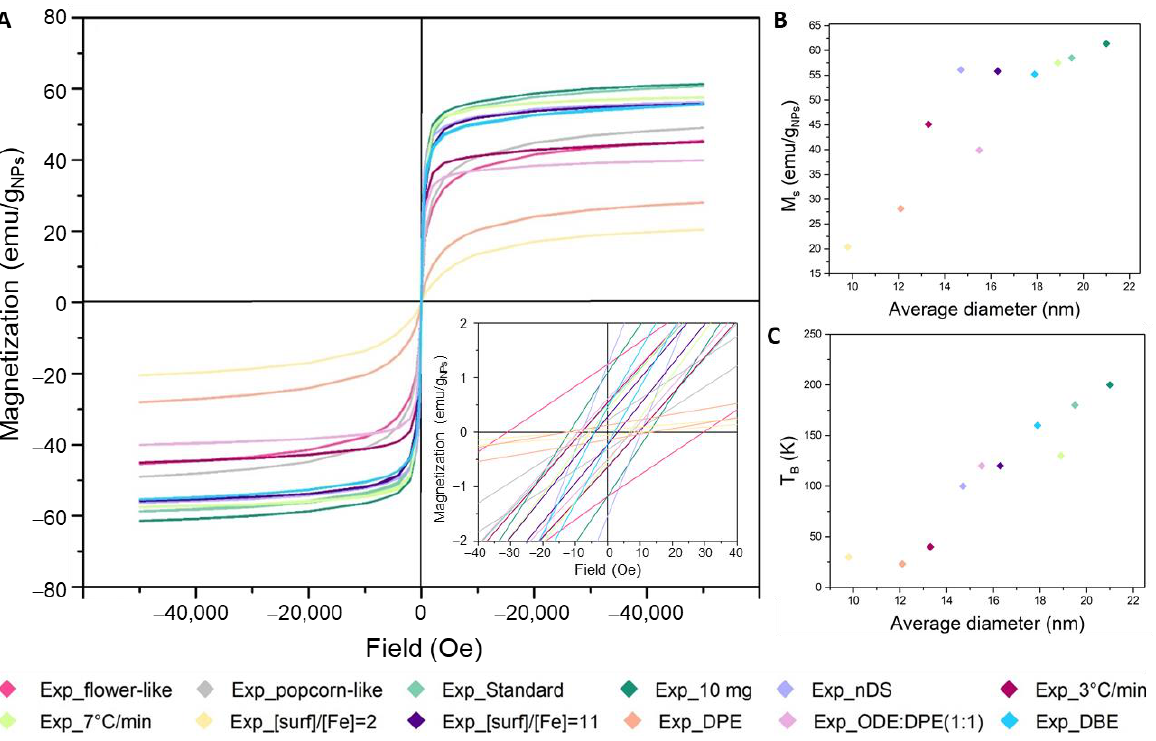
Figure 3. SQUID magnetometry of dry Pd/Fe-oxide NPs batches prepared under conditions summarized in Table 1: ( A ) M(H) T curves measured at T = 300 K; the inset represents 2400× magnification of the x -axis showing coercivities (H c ); ( B ) derived M S at 300 K as a function of the average diameter; ( C ) T B as a function of the average diameter of NPs. Table 3. Overview of the magnetic properties of Pd/Fe-oxide NPs. Saturation magnetization (M s ) at 60 kOe, T = 5 K and 300 K, coercivity (H c ) at T = 5 K and 300 K, and determined blocking temperature (T B ). Calculated SLP, ILP and r 2